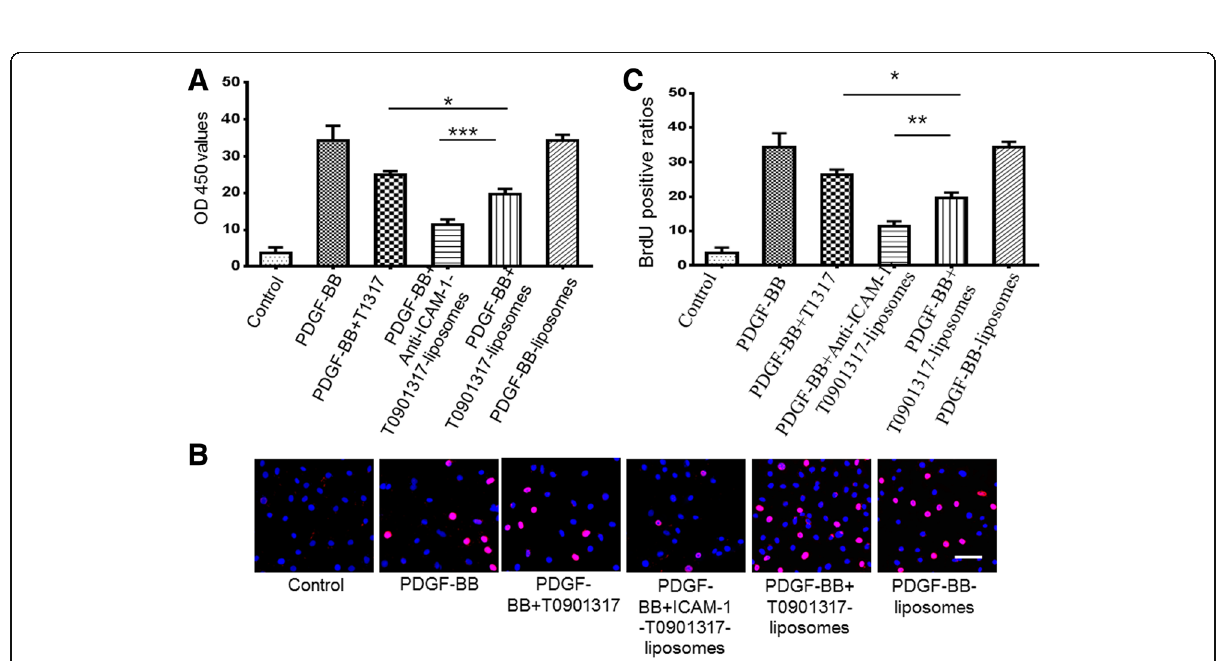
Fig. 6 Cell proliferation assessments using the CCK-8 assay and BrdU immunofluorescence ( a ). The CCK8 proliferation assay showed that anti-ICAM- 1-T0901317 liposomes prevented the proliferation of vascular smooth muscle cells (VSMCs) induced by PDGF-BB more substantially than T0901317 liposomes and T0901317. b Confocal images showing that administration of anti-ICAM-1-T0901317 liposomes decreased the number of BrdU+ cells following treatment with PDGF-BB (20 μ g/mL) for 24 h more substantially than T0901317- liposomes or T0901317. Bars = 100 μ m. c Graphs of BrdU- positive ratios. All the experiments were repeated three times and represented as the means ± SEM. * P < 0.05; ** P < 0.01; *** P <